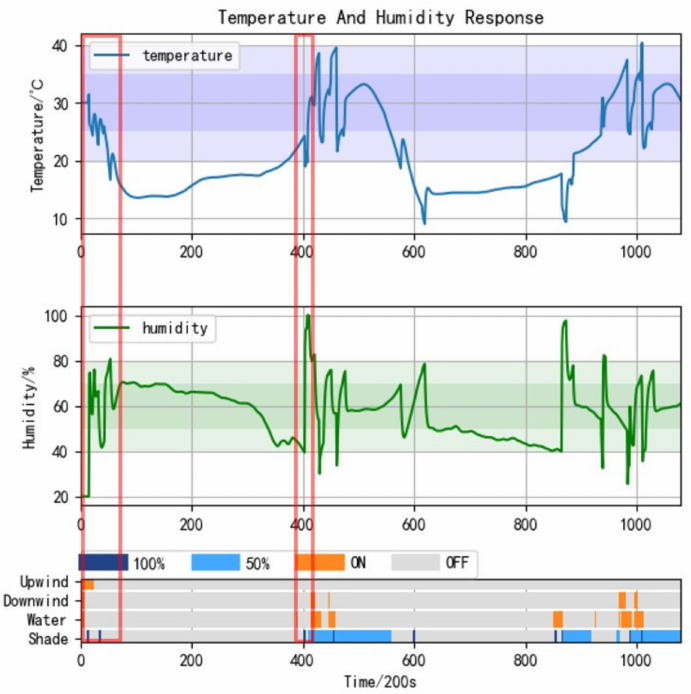
Figure 18. Simulate the results of the experimental CEP system